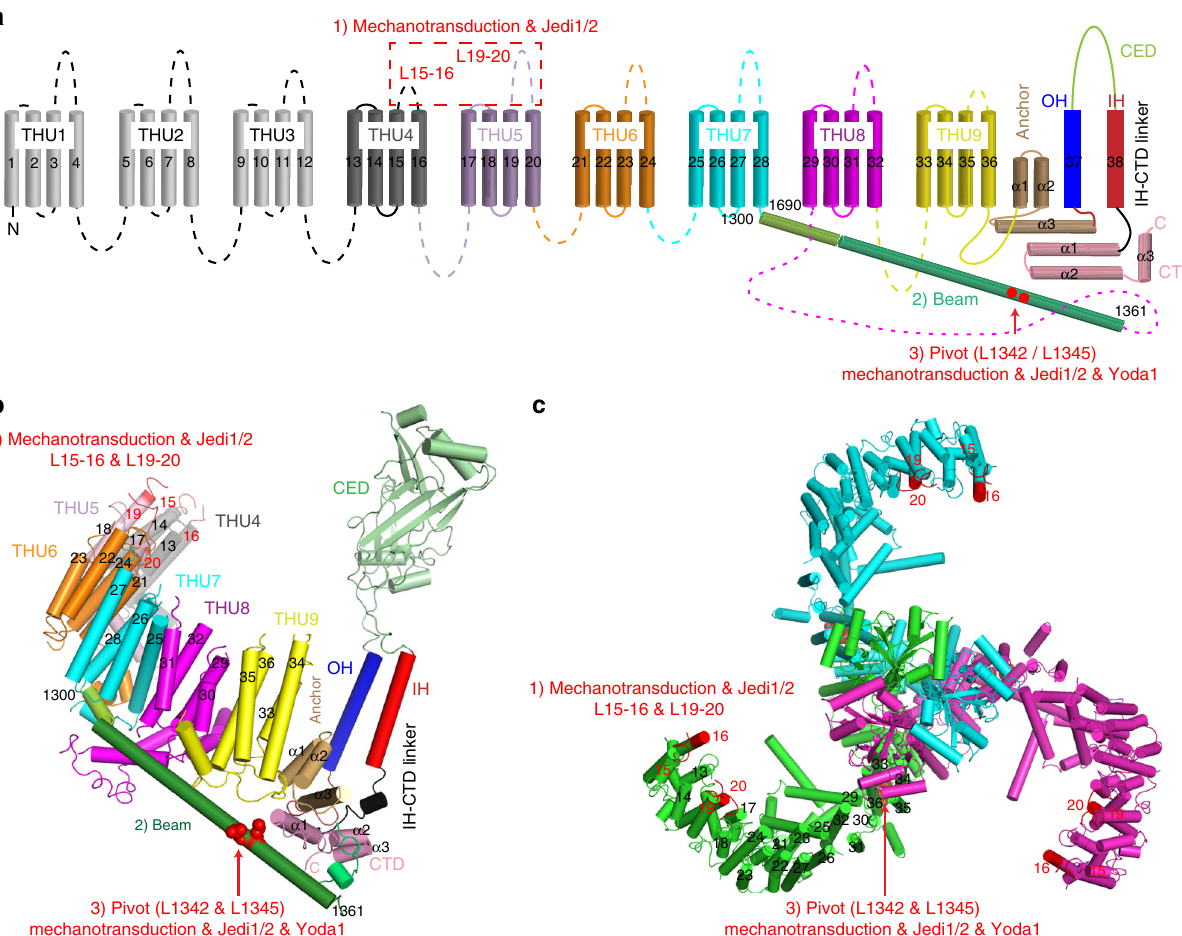
Fig. 1 Topological and structural illustration of the designated mechanical and chemical activation of Piezo1. a , b A topological model ( a ) and structural model (based on the PDB 5Z10) ( b ) of Piezo1 showing the featured domains revealed from the reported cryo-EM structure of Piezo1 39 , including the nine repetitive THUs, beam, anchor, and the C-terminal pore module comprising the OH, CED, IH, and CTD. The N-terminal THU1-THU3 were not structurally resolved. c Top view of the trimeric Piezo1 channel showing the three-bladed, propeller-like architecture and location of the L15-16 and L19-20 at the distal end of the blade. Key structural components involved in mechanical and chemical activation of Piezo1, including the extracellular loops of L15-16 and L19- 20, beam, and L1342/L1345 (proposed to form the pivot of the beam), are labeled in a – c . As illustrated in steps (1) – (3), the blade-beam might form a designated transduction pathway for propagating action from the extracellular side of the distal blade to the central pore via utilizing the intracellular beam as a lever-like